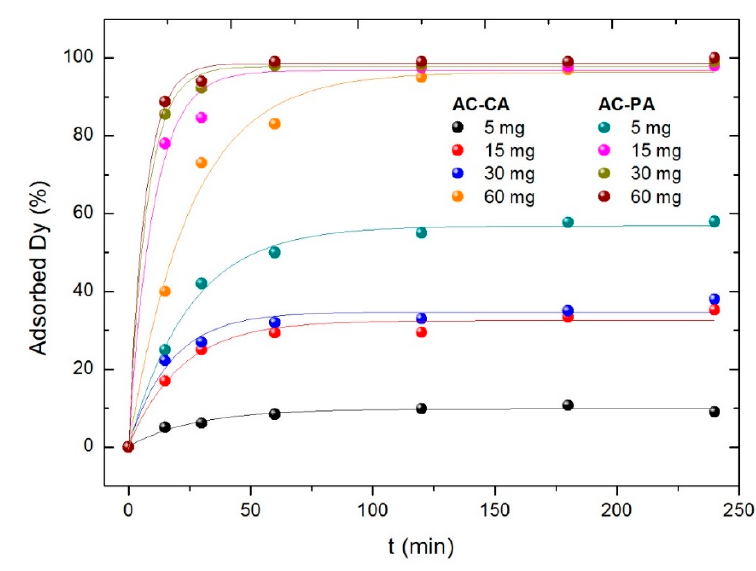
Figure 7. Variation of the adsorption percentage with the adsorbent amount.